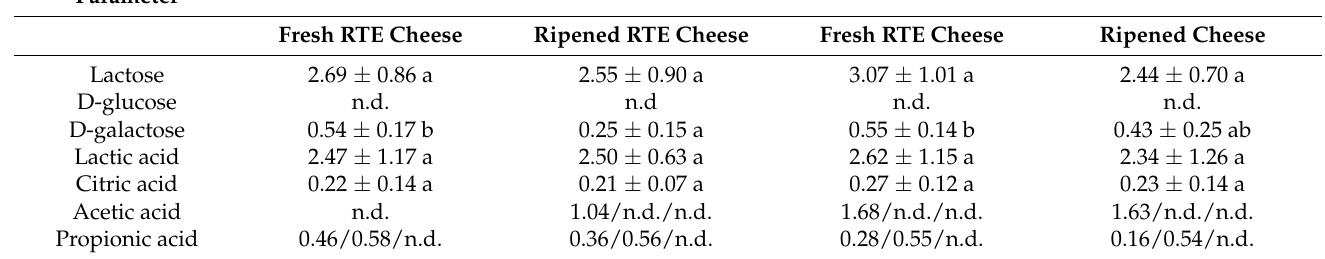
Table 4. Concentrations (g/100 g) of the main sugars and organic acids intraditional Galotyri PDO cheese fermented with or without supplementation of the basic starter LAB culture with the adjunct strain L. plantarum H25 1